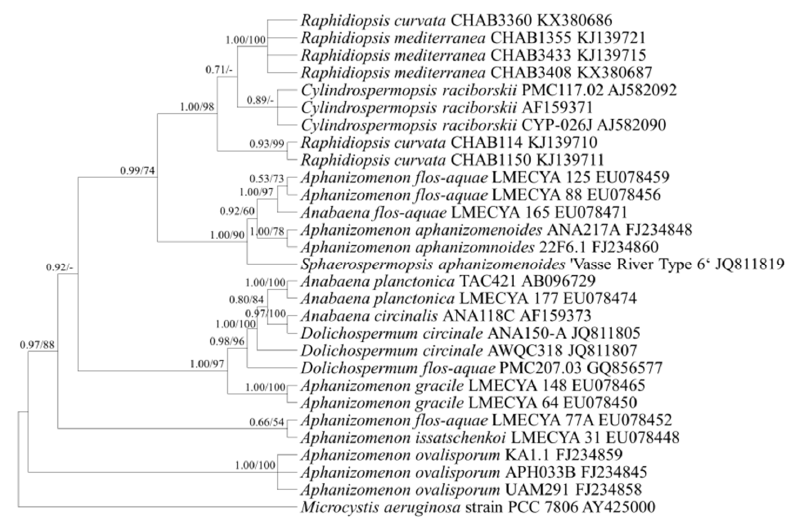
Figure 5. Consensus Bayesian tree based on aligned 373-bp sequences of rpoC1 using the GTR+G+I model with Microcystis aeruginosa as an outgroup. The parameters were as follows: assumed equal nucleotide frequency; substitution rate matrix with A–C substitutions = 0.0455, A–G = 0.4384, A–T = 0.0295, C–G = 0.0844, C–T = 0.3488, and G–T = 0.0531; proportion of sites assumed to be invariable = 0.4420; and rates for variable sites assumed to follow a gamma distribution with the shape parameter = 1.1548. The branch lengths are proportional to the amount of character changes. The numbers above the branches indicate the Bayesian posterior probability ( left ) and maximum- likelihood bootstrap values ( right ). Posterior probabilities ≥ 0.5 are